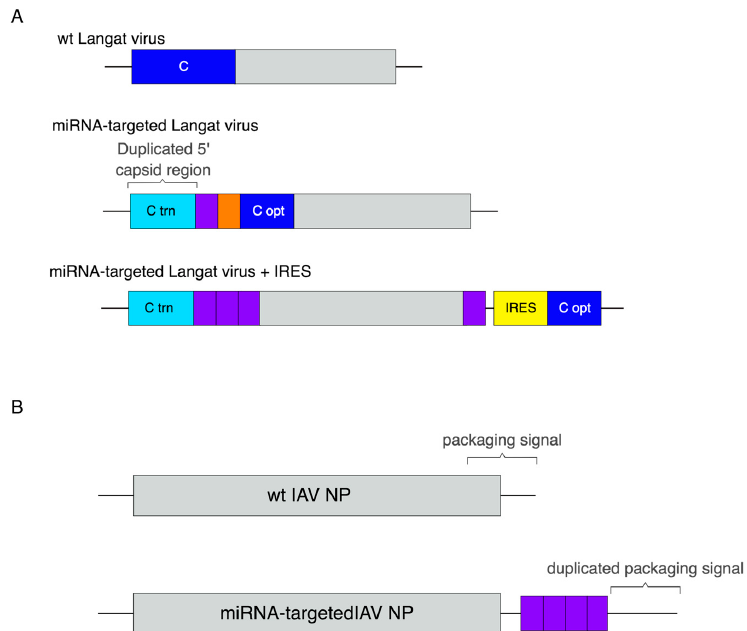
Figure 2. Altered viral genome structures to improve miRNA targeting. ( A ) Model of the wild type Langat virus genome, highlighting the capsid gene (top), the miRNA-targeted (purple) duplicated 5’ region followed by a 2A site (orange) to allow for expression of the codon-optimized capsid protein (middle), and the insertion of an IRES to regulate the expression of the capsid protein (bottom). ( B ) The wild type influenza virus NP gene (top) and the miRNA-targeted (purple) NP gene with a duplicated packaging signal (bottom). Created with BioRender (Toronto, ON, Canada).